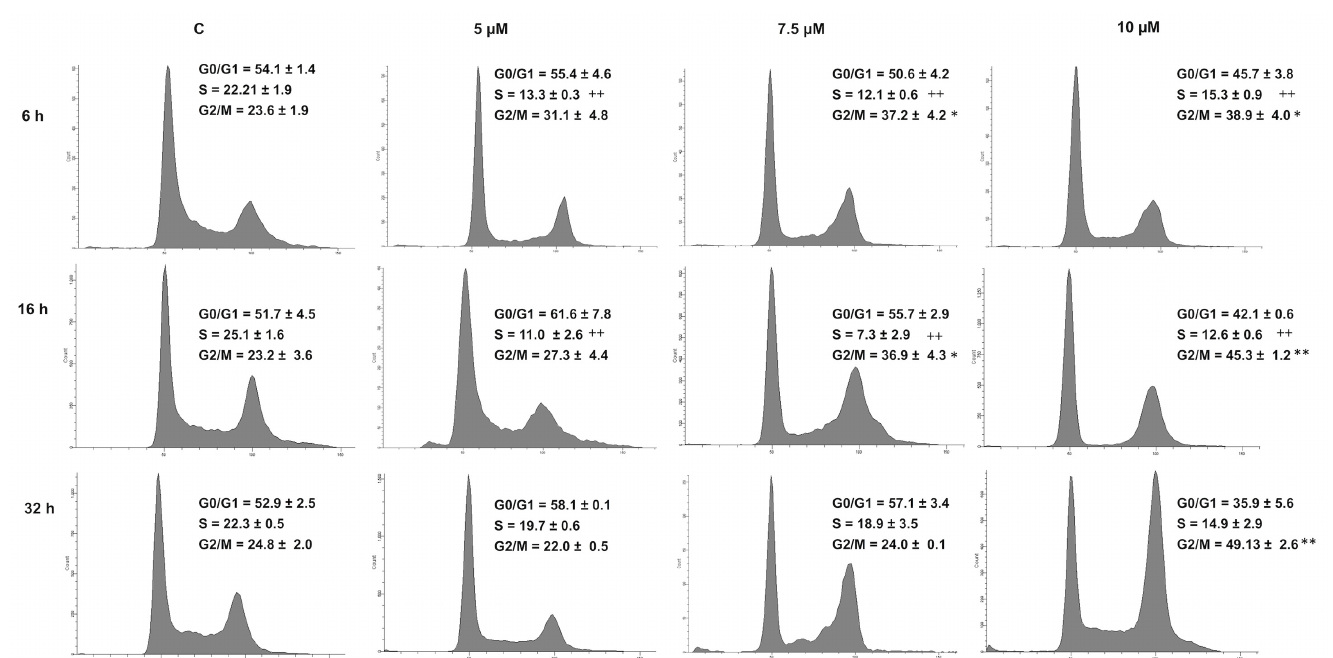
Fig 3. DhL induced cell cycle arrest in D384 cells. Cell cycle analysis. D384 cells were exposed to 0 (C-, control), 5, 7.5 and 10 μ M of DhL for 6, 16 and 32 h. The fraction of cells in the G1, S, and G2/M-phases of the cell cycle was then analyzed using a FACSCanto II flow cytometer. Data were acquired and analyzed using DIVA software. A representative histogram is shown for each DhL concentration. Data represent the mean ± SEM, n = 4. Symbols denote statistically significant differences: * p < 0.01 and ** p < 0.001 with respect to control conditions for G2/M phase and ++ p < 0.001 with respect to control conditions for S